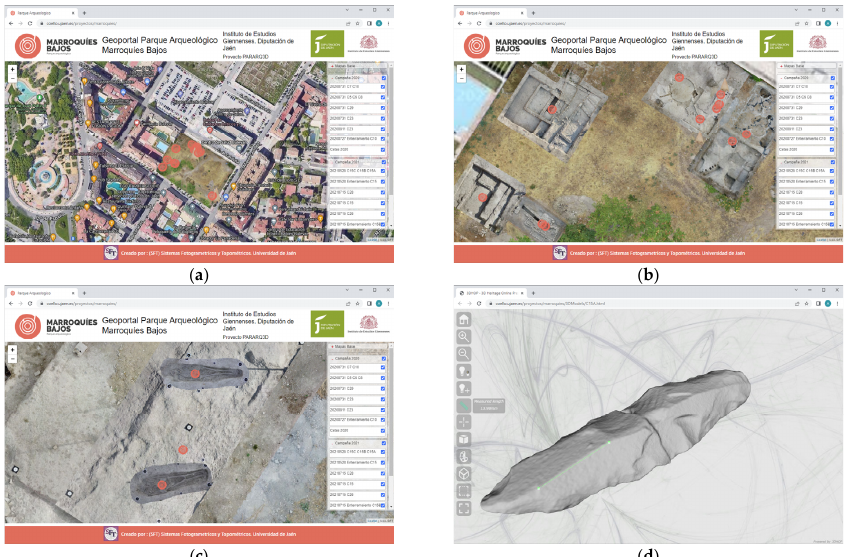
Figure 8. Website developed in this study: ( a ) general view of the archaeological area; ( b ) view in ‐ cluding an orthoimage of an excavation test (SL2–S4), including three orthoimages of burials (SL3– S3); ( c ) detailed view including the orthoimage of an excavation test as background, an orthoimage including a specific subarea, where two burials were located and two orthoimages of these burials; ( d ) 3D view of an excavation test